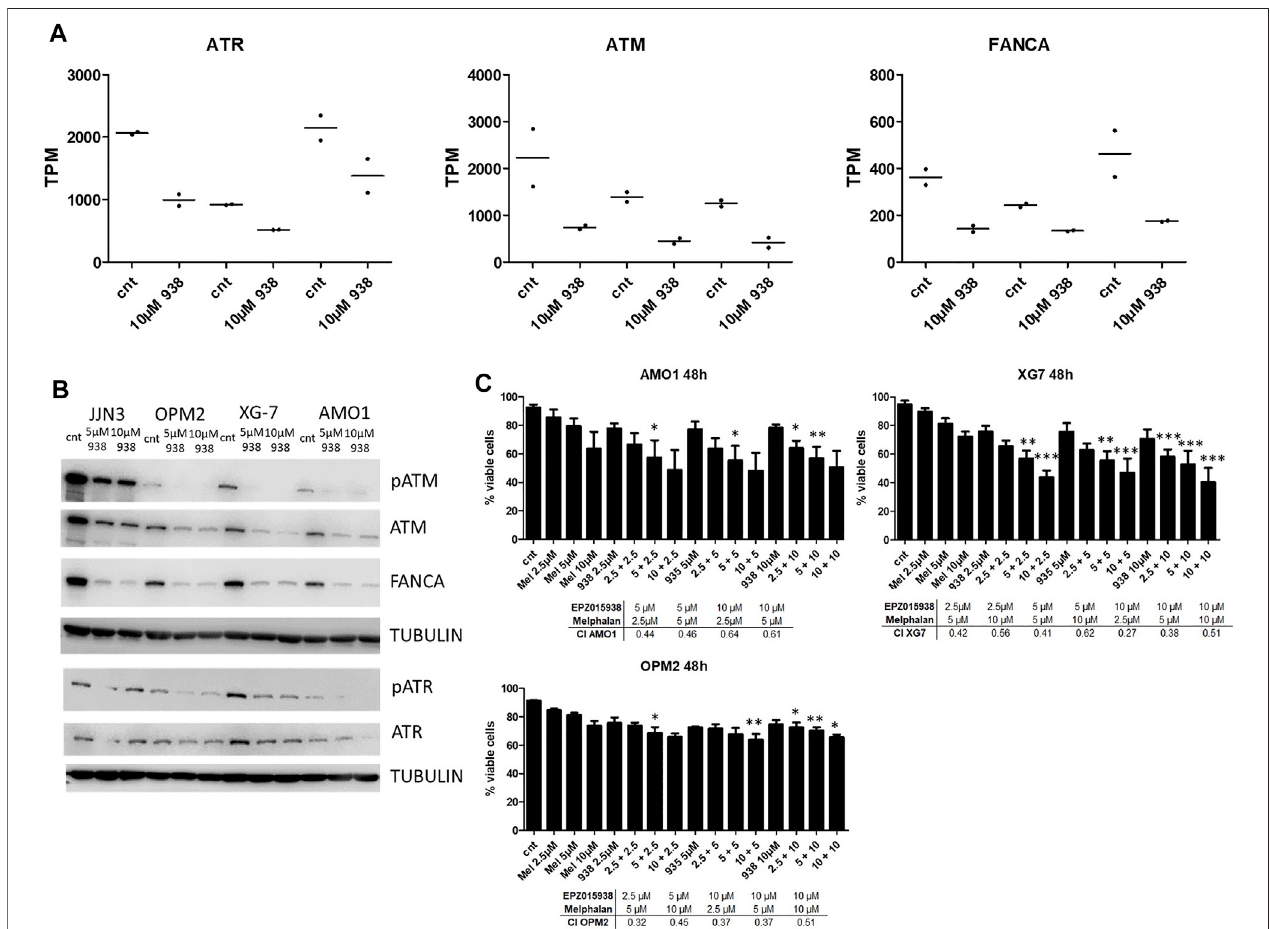
FIGURE 3 | (A) : TPM values for ATR, ATM and FANCA for both control and EPZ015938 cells, showing decrease in transcript abundancy following PRMT5 inhibition in all 3 cell lines studied ( n = 2 for each cell line and condition, no error bars are shown). (B) : Western blot analysis was performed on JJN3, OPM2, XG7 and AMO1celllysatestoevaluateATM/ATRandFANCAproteinlevelsuponPRMT5inhibitionfor3consecutivedays.Tubulinwasusedasaloadingcontrol.Oneexperiment representativeof3experimentsperformedisshown( n =3). (C) :ViabilityassayusingAnnexin/7AAD-stainingofHMCLsaftertreatmentwithEPZ015938,melphalan or combination therapy at depicted concentrations. Samples were analysed using an ANOVA selected pairs test. to evaluate differences between different treatment settingsandagainstcontrolsamplesandsamplestreatedwithonlyEPZ015938ormelphalan.Errorbarsrepresentmean+SD;*/**/***denotes p < 0.05, p < 0.01and p < 0.001 respectively ( n = 3). Synergy was evaluated for between both compounds by calculation of the combination index (CI) for signi fi cant combinations, with a CI < 1 showing a synergistic effect.